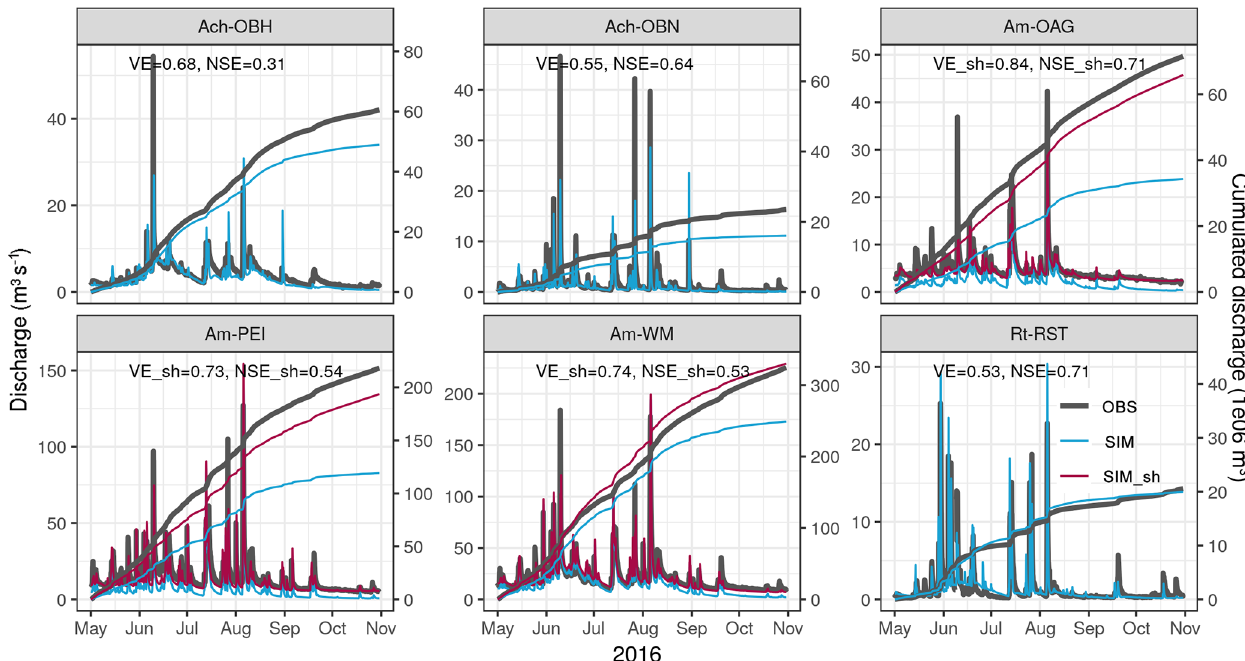
Figure 5. Subcatchment hydrographs for the validation period (1 May–31 October 2016). Standard WRF-H_SA model output is printed in blue. Shifted (sh) hydrographs are shown in red. Shift amounts are listed in Table